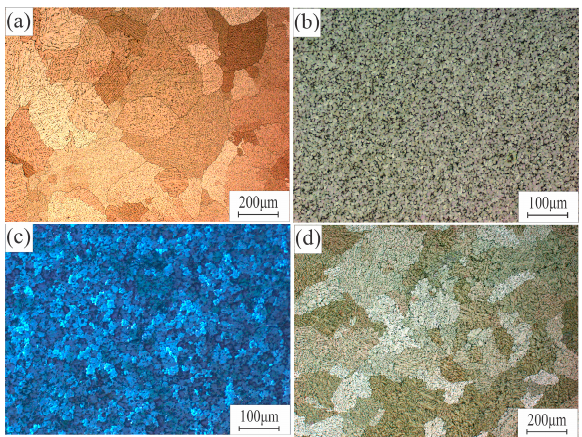
Figure 1. Typical microstructure of the Al–Zn–Mg–Cu alloy: ( a ) AA7075 standard, ( b ) AA7075-ScZr, ( c ) AA7075-TiB, ( d ) AA7075-FeNi.